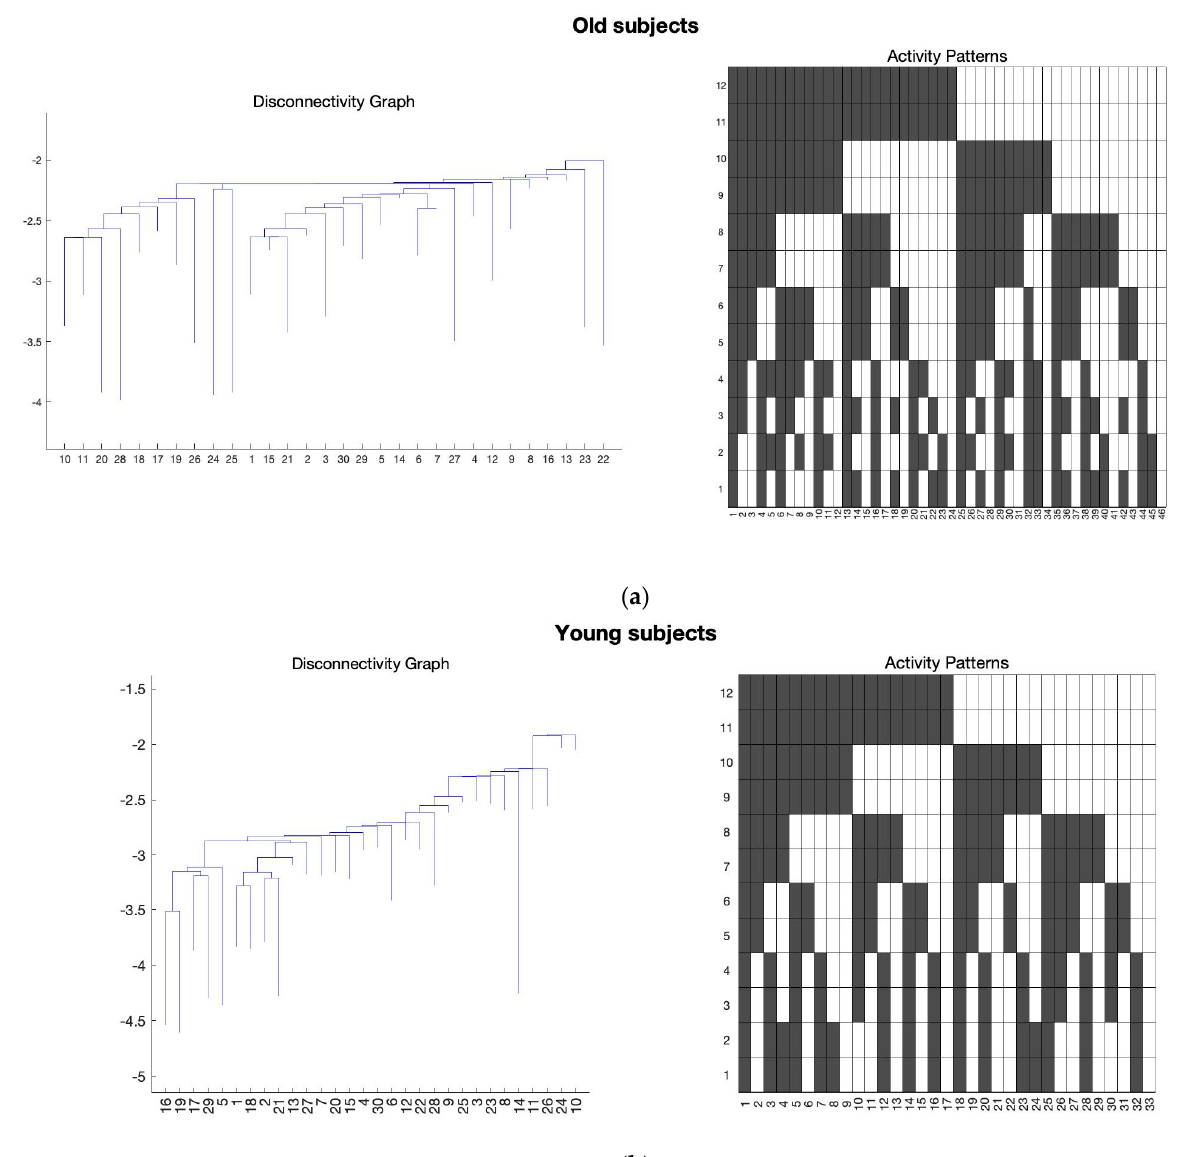
Figure 2. The average of all the subjects for the SAN was taken and the energy landscape analysis was conducted to generate the disconnectivity graph and activity pattern. Here, the x -axis of the disconnectivity graph represents the local minima number and y -axis shows its corresponding energy value. For the activity patterns, x -axis is the local minima number and y -axis shows the ROIs for SAN. ( a ) Energy landscape analysis conducted on the average of the old subjects for SAN. ( b ) Energy landscape analysis conducted on the average of the young subjects for SAN.